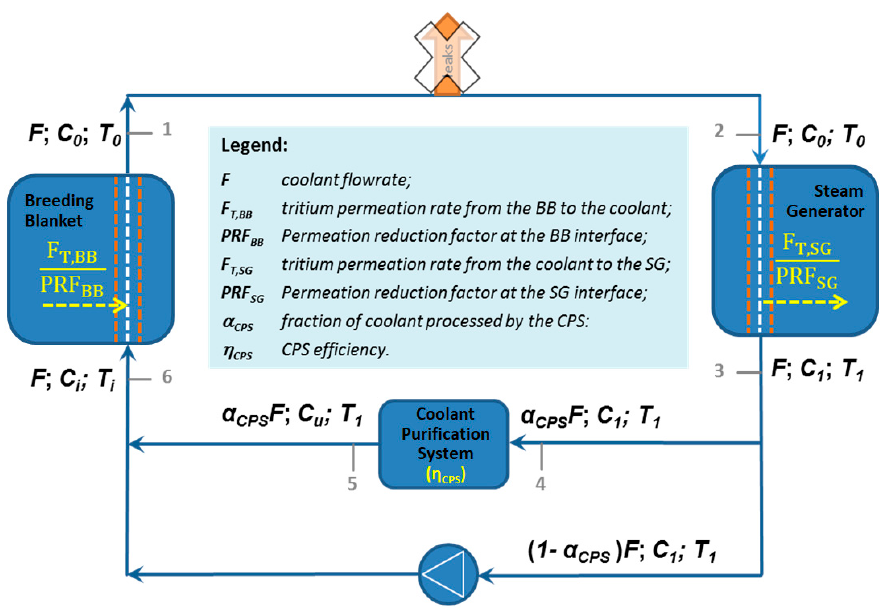
Figure 2. Simplified scheme of the coolant loop and CPS used for tritium mass balance.